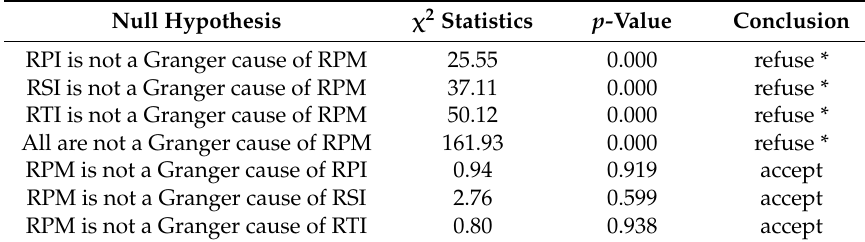
Table 5. Granger causality test results.